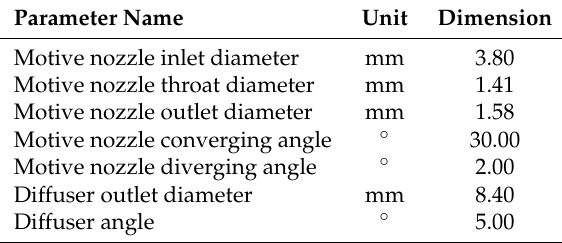
Table 1. The main geometry parameters of the R744 two-phase ejector installed in the multi-ejector module